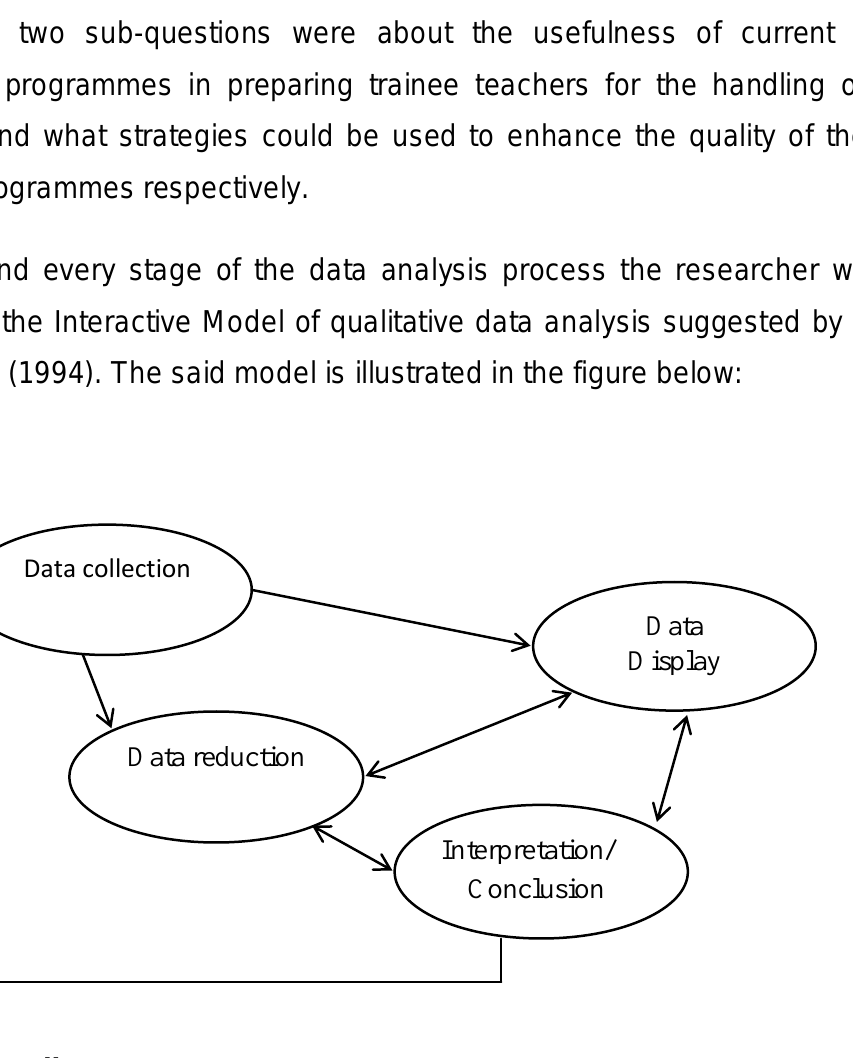
Figure 3.1. Miles & Huberman’s qualitative